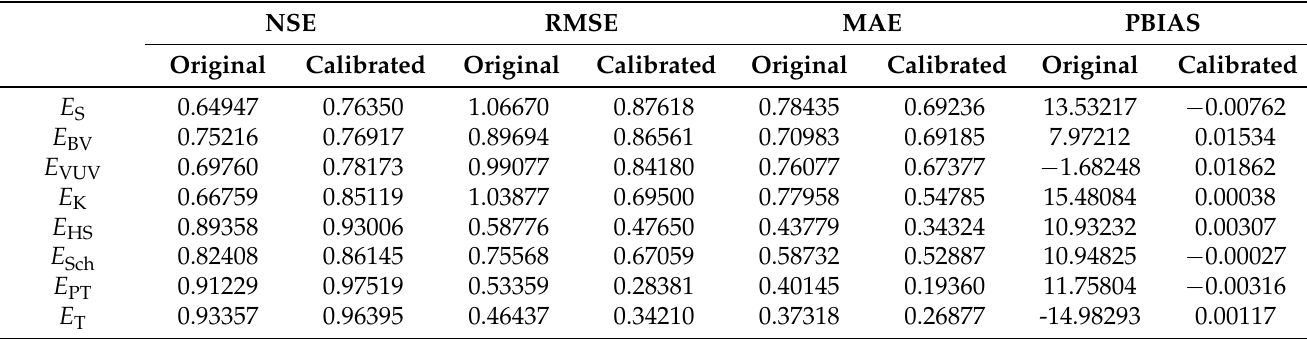
Table 1. The comparison of statistical measures before and after the calibration process. These values have been computed on the whole data set and correspond to the models presented in Table